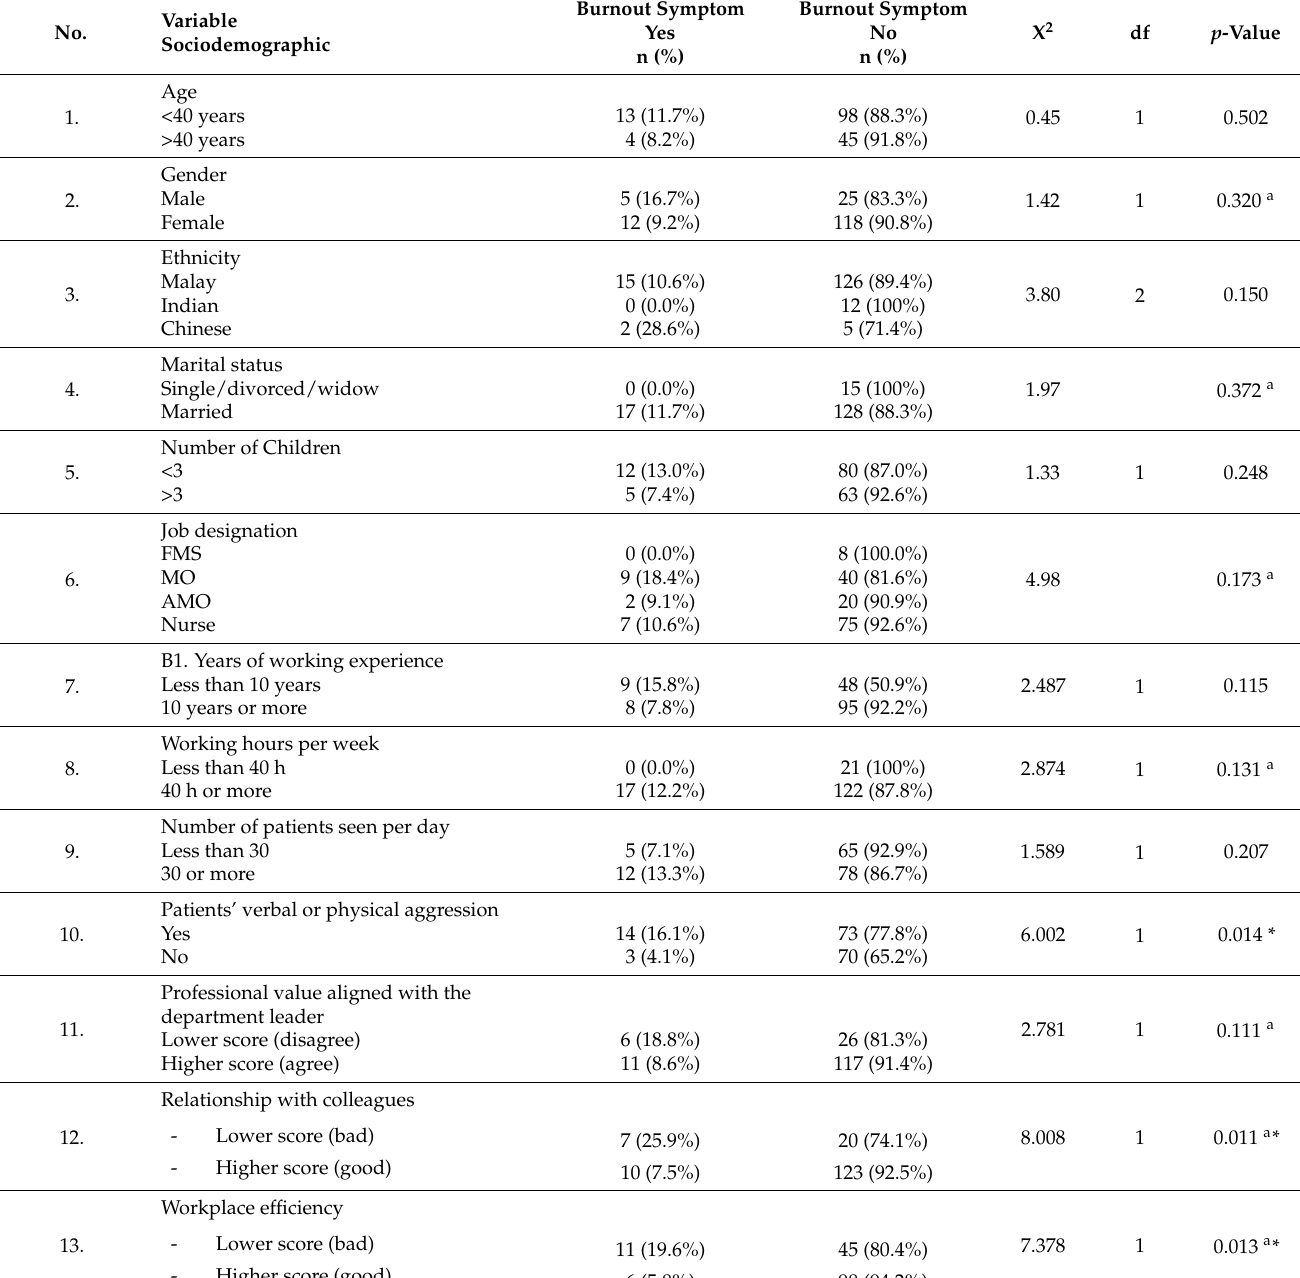
Table 3. Result of bivariate